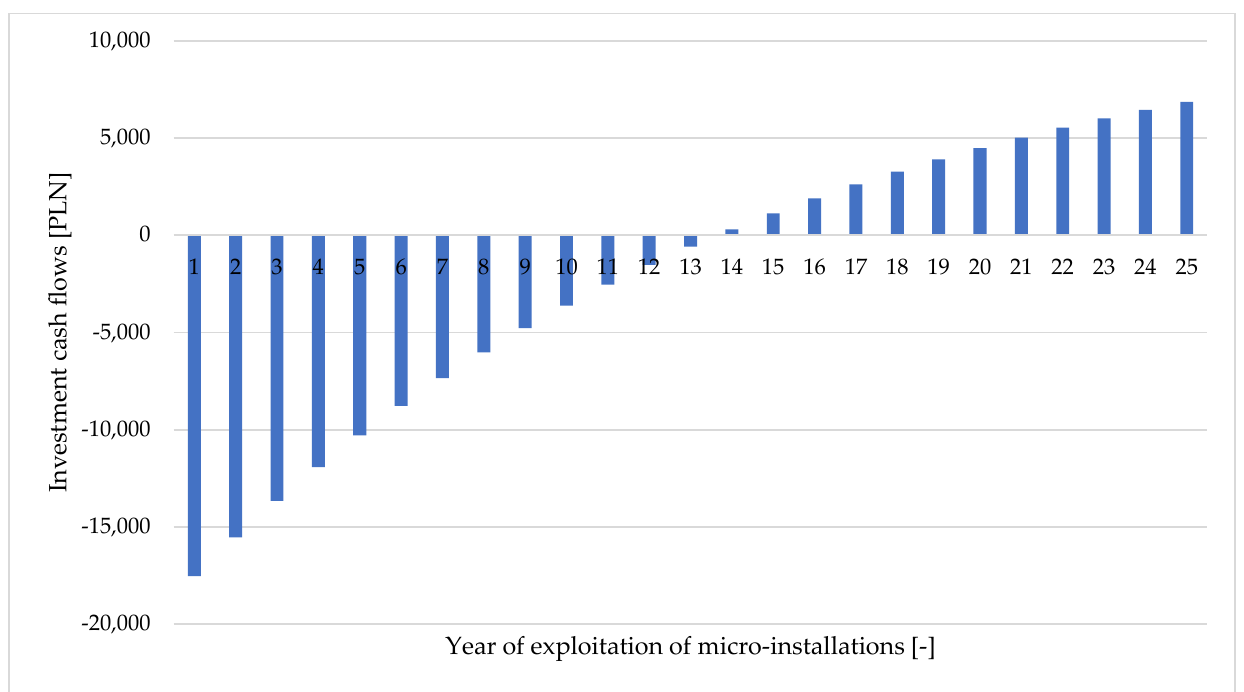
Figure 10. Graph showing the investment cash flow as a function of time of operation for the net-billing system based on monthly prices and a 50% self-consumption level.